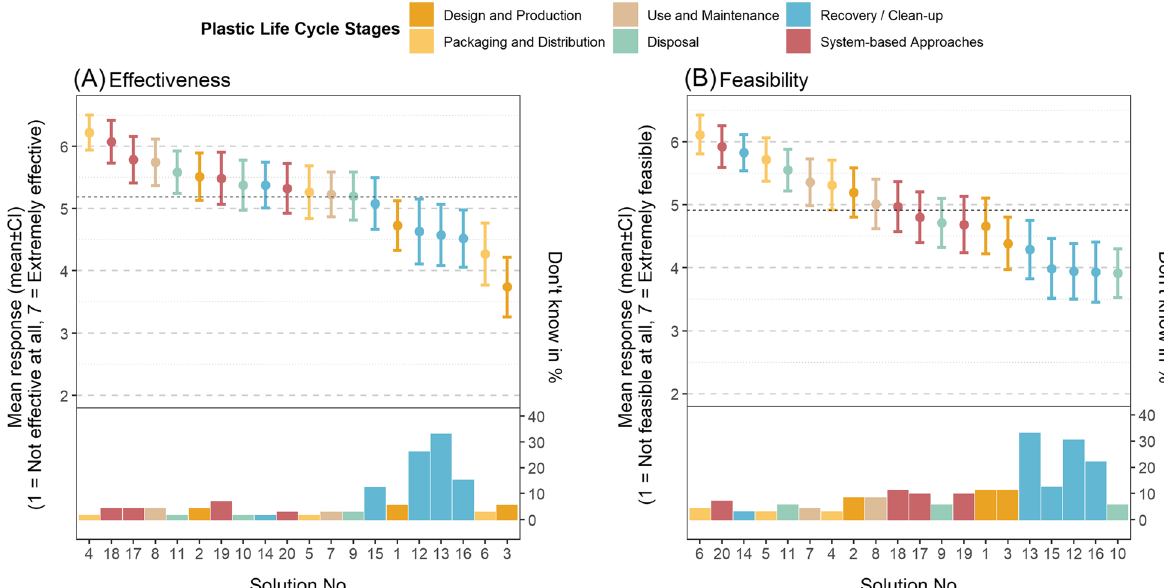
Fig. 3 Mean level of solutions (A) effectiveness and (B) feasibility ratings (with 95% CI), overall mean (indicated as dotted line) and separated don’t knows in percentage (separated by solid line) of 20 potential microplastics solutions across the plastic life cycle and system approaches. Microplastics solutions : (1) Different construction of synthetic materials for clothing (e.g. yarn type, textile construction) to reduce shedding of fibres; (2) Simplified design of products, e.g., avoidance of films and mixtures of different plastic types to facilitate recycling; (3) Increased use